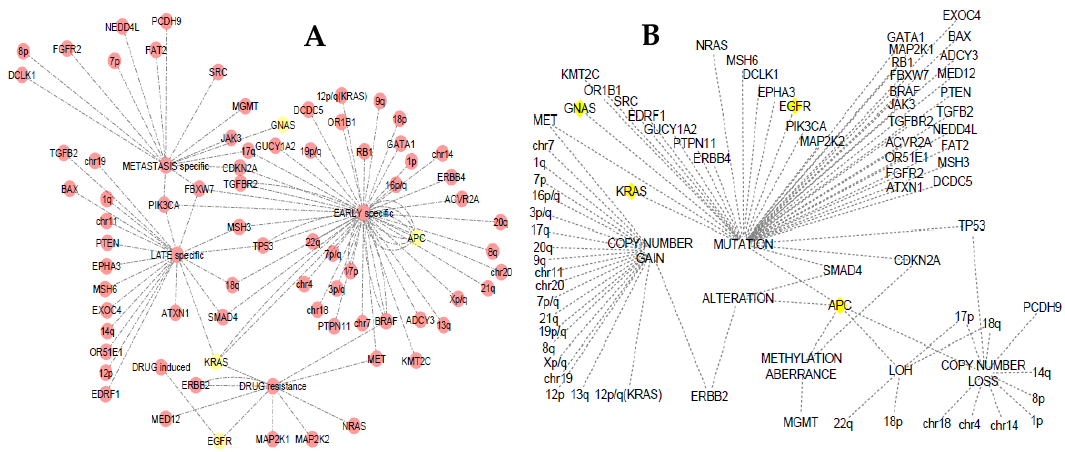
Figure 3. Evolutionary stage-specific somatic events in colorectal cancer (CRC). ( A ) stage-specific targets. ( B ) variant types and specific variants of the microRNA target genes. Yellow nodes indicate the microRNA target genes.